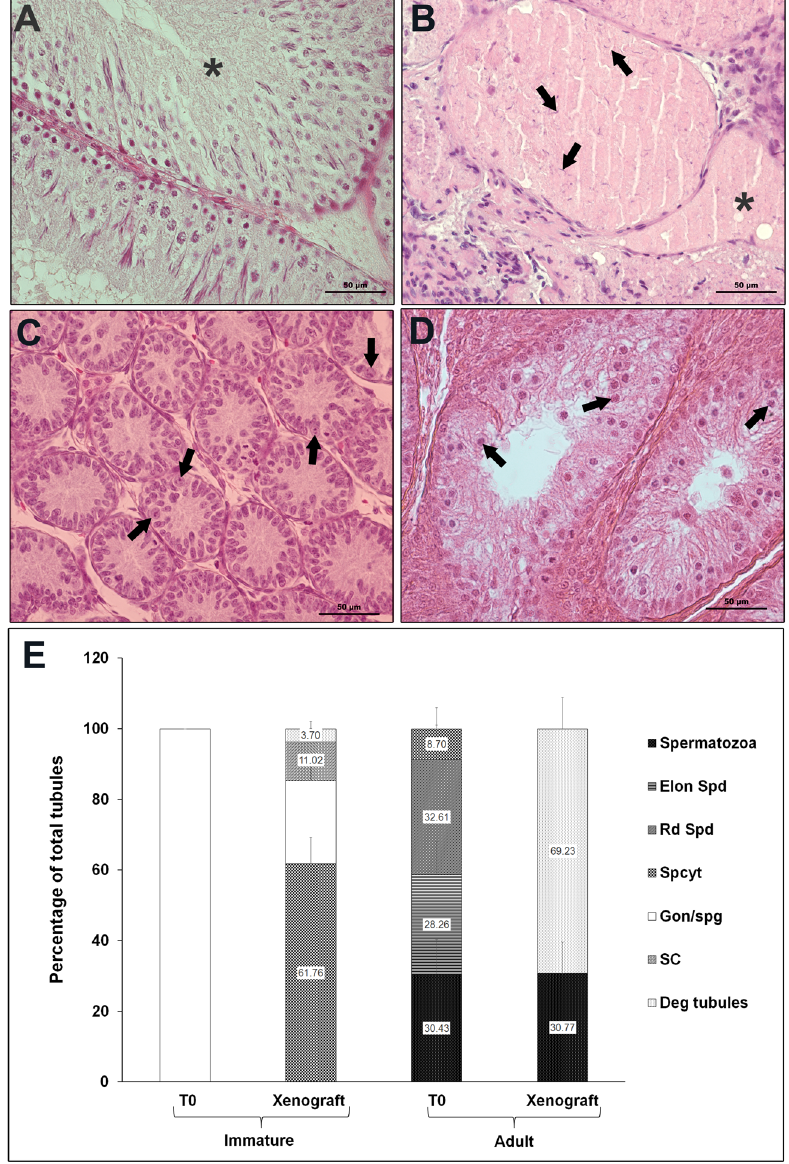
Figure 1. Histological examination and quantitative assessment of seminiferous tubules for the most advanced germ cell type. ( A ) In adult donor tissue from 10-wk-old rat (T0). Seminiferous tubule with normal spermatogenesis is indicated by an asterisk. ( B ) In adult rat testis xenograft at 8-wk-post grafting. Degenerated seminiferous tubules are indicated by asterisks and arrows indicate sperm. ( C ) In immature donor tissue from 6-day-old rat (T0). Note that the most advanced germ cells at this age were gonocytes/spermatogonia (arrows). ( D ) In immature rat testis xenograft at 8-wk -post grafting. Note that the most advanced germ cells identified in the xenografts were pachytene-stage spermatocytes (arrows). ( E ) Percentage of seminiferous tubules with the most advanced germ cell type. Deg tubules, degenerated tubules; SC, Sertoli cell only; Gon/spg, gonocytes or spermatogonia; Spcyt, pachytene spermatocytes; Rd Spd, round spermatid; Elon Spd, elongated spermatid; Spermatozoa, spermatozoa. Data are presented as mean ± SEM. Bars with different letters are significantly different at P < 0.05. Scale bar = 50 µ